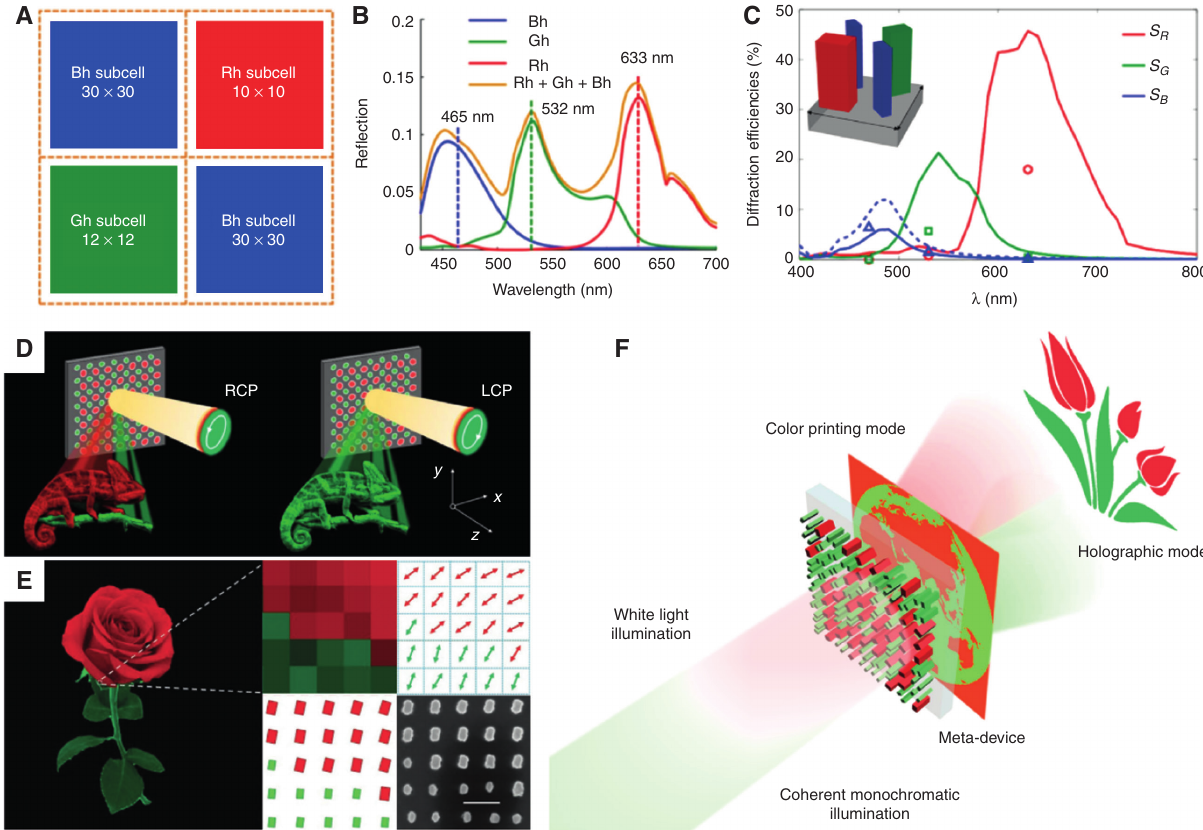
Figure 12: Wavelength-selective metasurfaces for color holography and printings. (A and B) Supercell design with three kinds of nanostructures for color holograms [95]. (C) Ultracompact supercell to produce different spectral responses for red, green, and blue light [96]. (D) Color-varied hologram with different helicity of incident light [97]. (E) Two-color printings with silicon nanobricks [98]. (F) Combination of printings and holography with a single metasurface [99]. Reprint permission obtained from